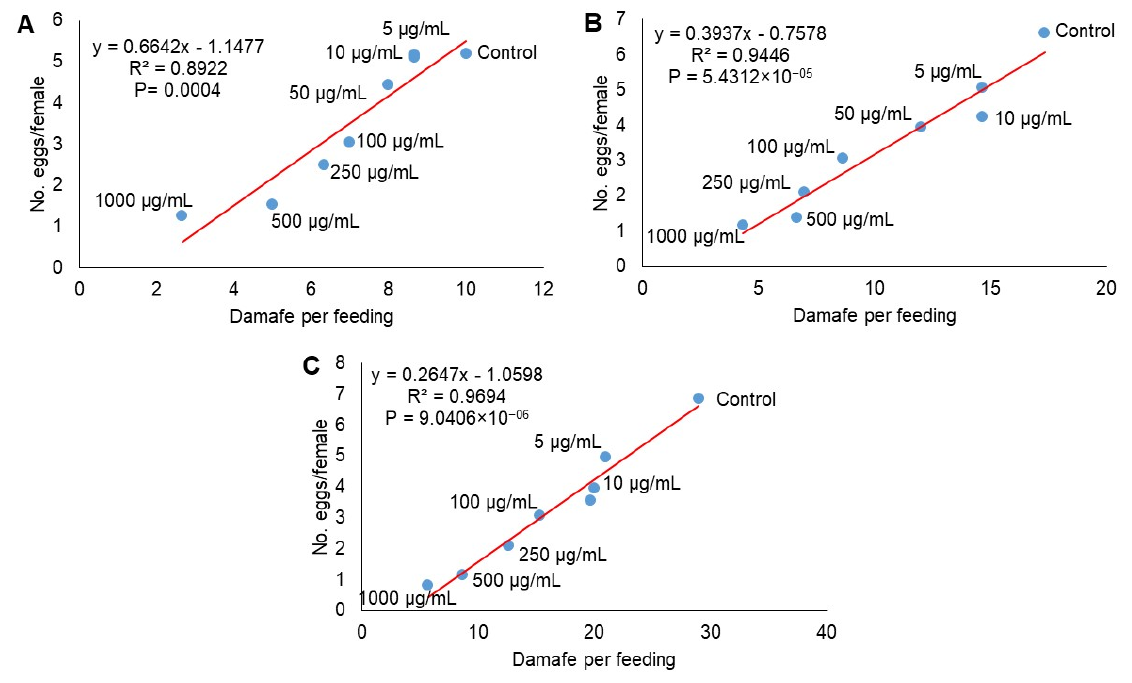
Figure 3. The correlation between the number of eggs laid per female and percentage of feeding damage of Oligonychus punicae treated with different concentrations of ethanolic powdered extract of Magnolia tamaulipana leaves at 24 h ( A ), 48 h ( B ), and 72 h ( C ).